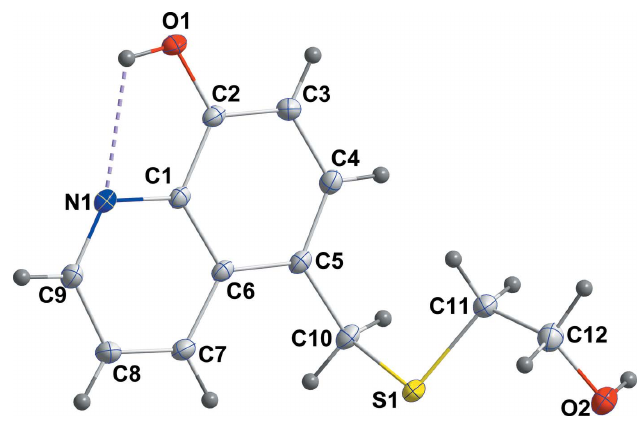
Figure 1 The title molecule with the atom-labelling scheme and 50% probability ellipsoids. The intramolecular O—H (cid:2)(cid:2)(cid:2) N hydrogen bond is shown by a dashed line.